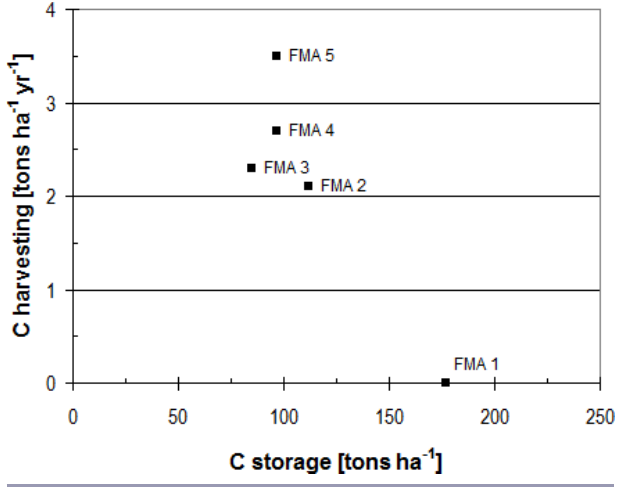
Fig. 4 . Carbon in harvested products versus average carbon storage in above-ground living and dead biomass for the five forest management approaches